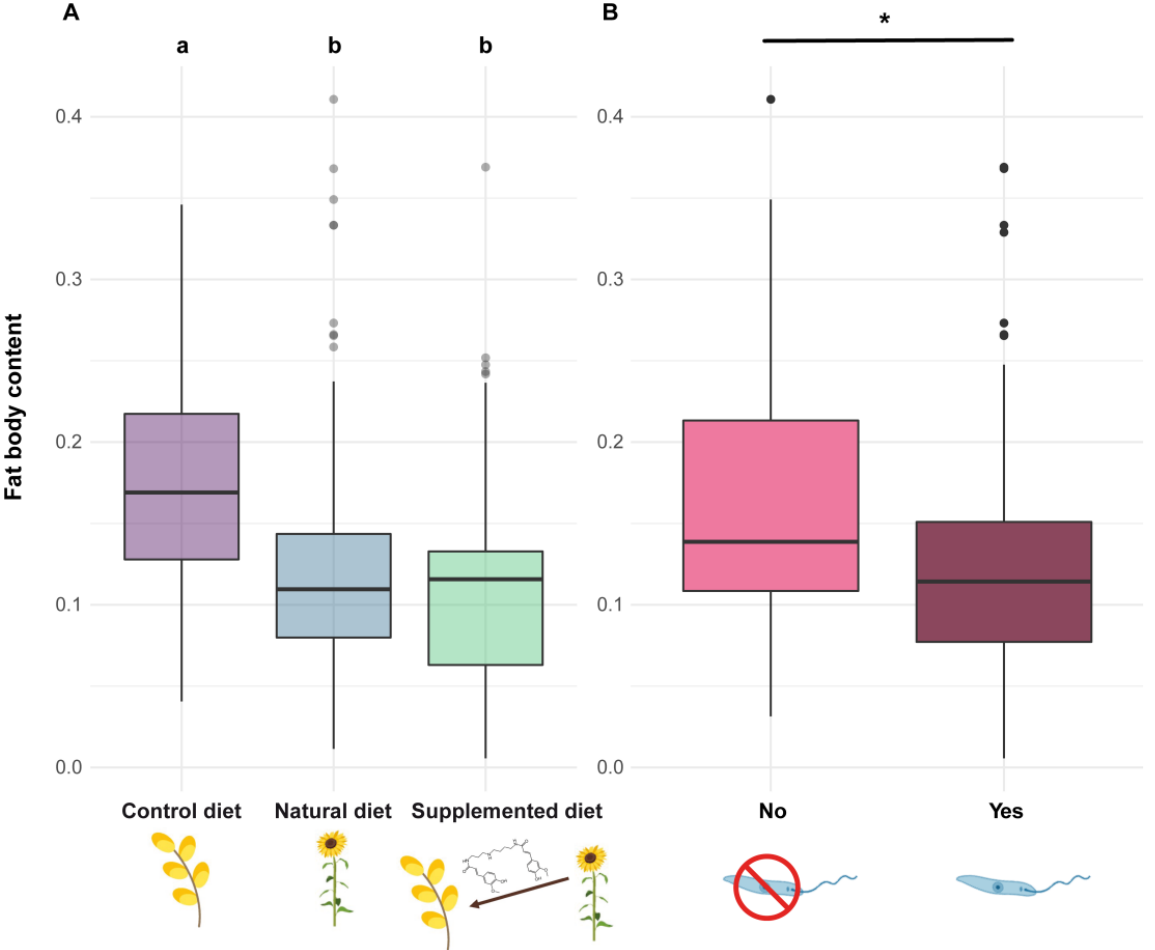
Figure 6. Fat body content in Bombus terrestris individuals. Fat body content is measured as a proportion and has therefore no unit. ( A ) Two diets sharing a letter are not significantly different (GLMMs). ( B ) The asterisk (*) indicates significant differences between parasite treatments (GLMMs).